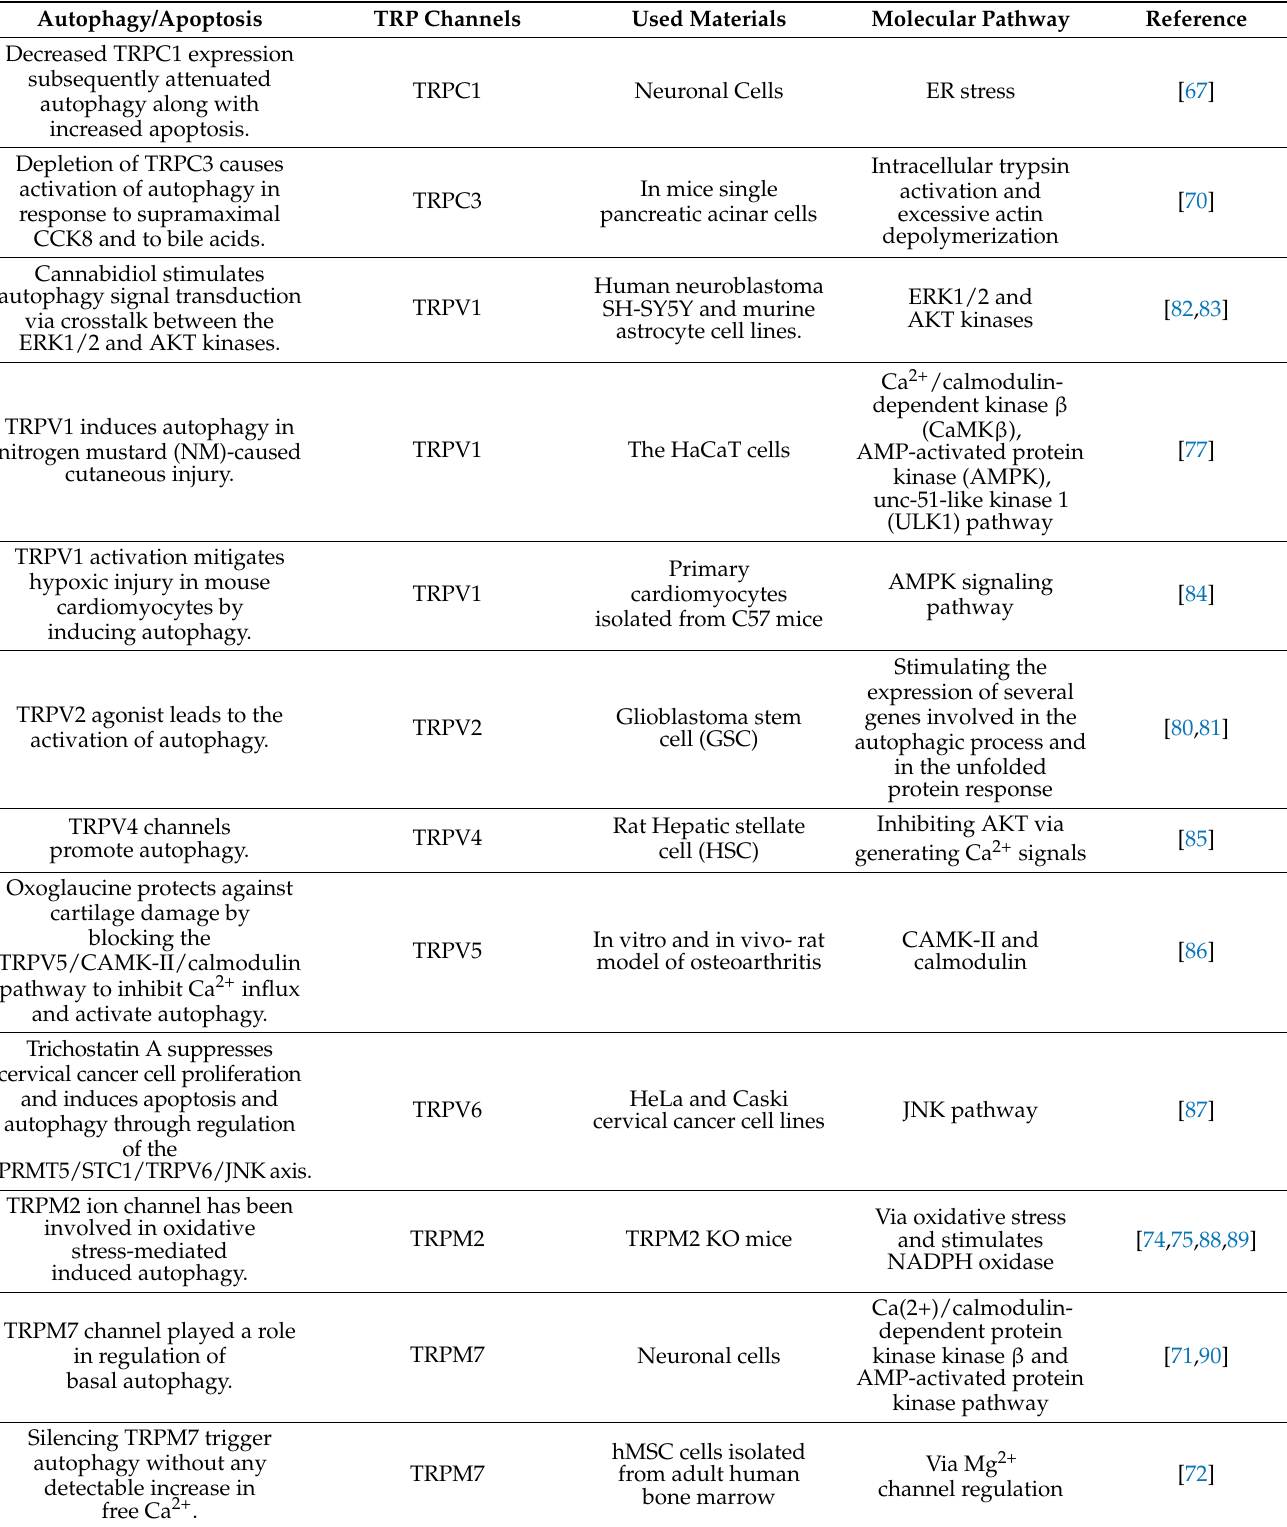
Table 1. Calcium channels and their modulation in cellular